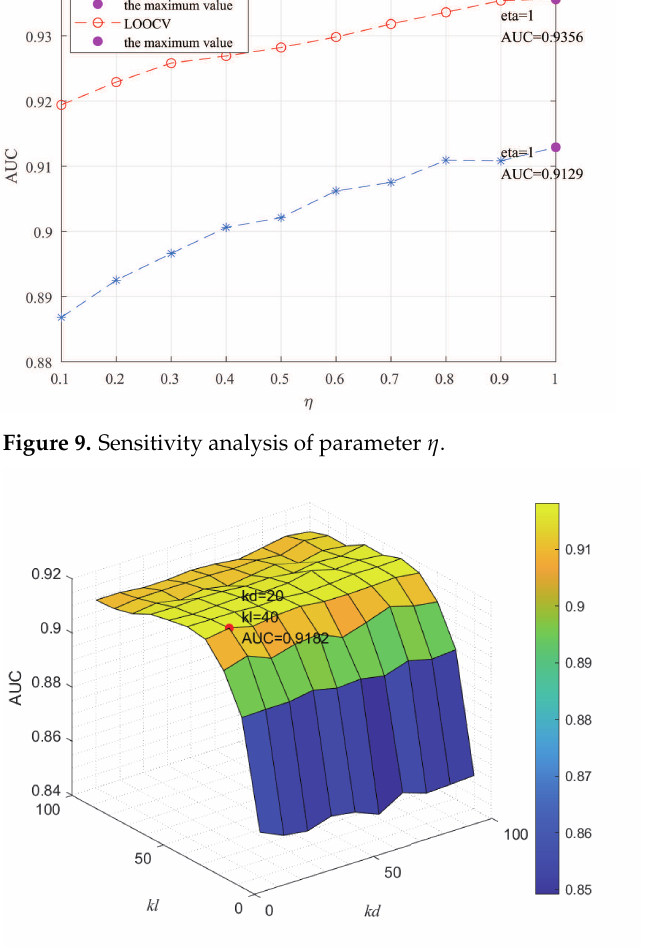
Figure 10. Joint sensitivity analysis of parameters k l and k d